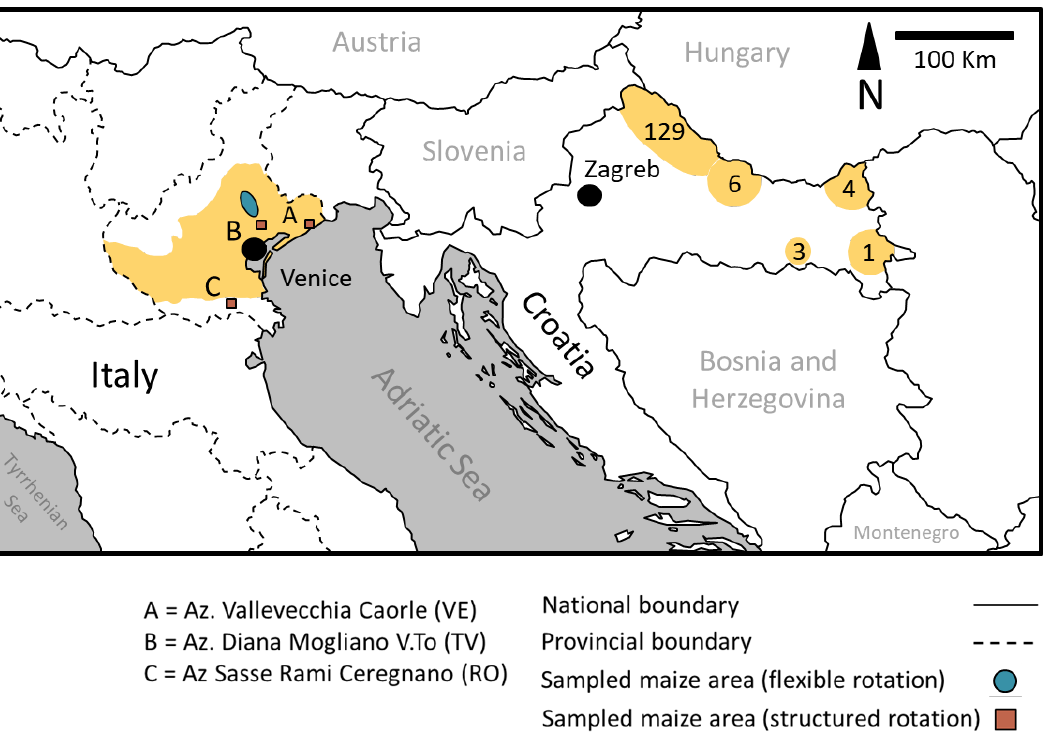
Figure 1. Map showing the regions in Italy and Croatia surveyed for WCR damage between 2003 and 2017. The locations of Venice and Zagreb are indicated by black circles. Orange coloring indicates areas surveyed for risk factors in Italy and Croatia. The numbers associated with surveyed areas in Croatia indicate the numbers of fields that were monitored. In Veneto, Italy, monitored fields were distributed throughout the entire maize cultivation area. Red symbols indicate the areas in Italy where farmers applied structural crop rotation and the blue symbol indicates the area where farmers applied flexible crop rotation. In Croatia, no comparisons of crop rotation regimes were conducted.